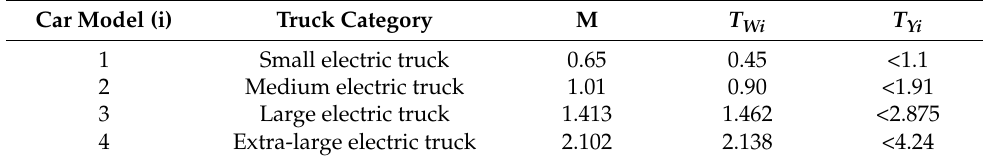
Table 5. Dynamic wireless charging expressway toll